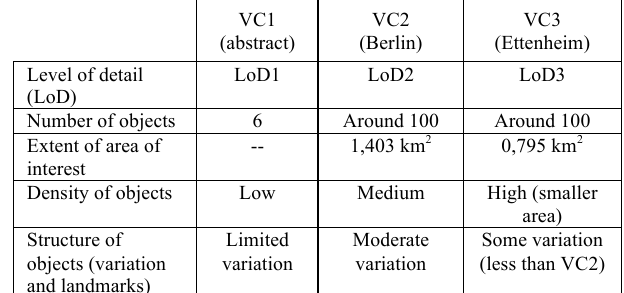
Table 1. Visual complexity levels in this experiment.